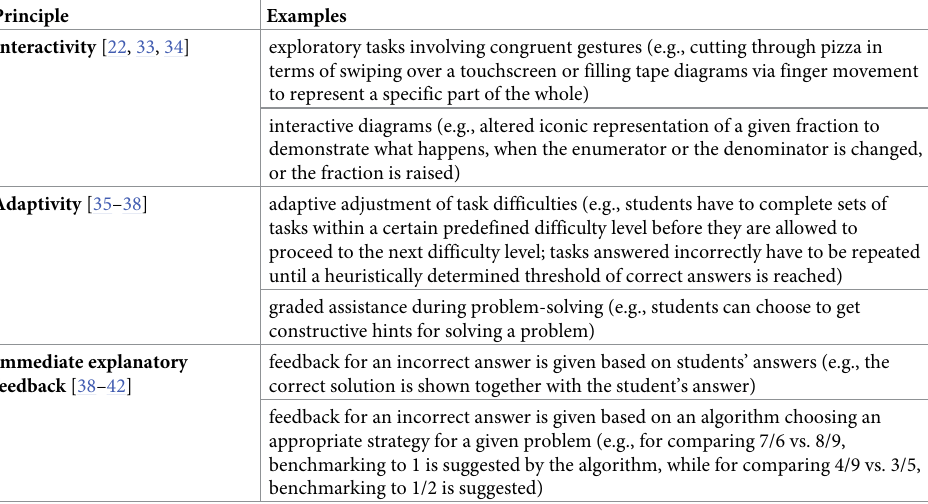
Table 1. Principles to support learning in disadvantaged